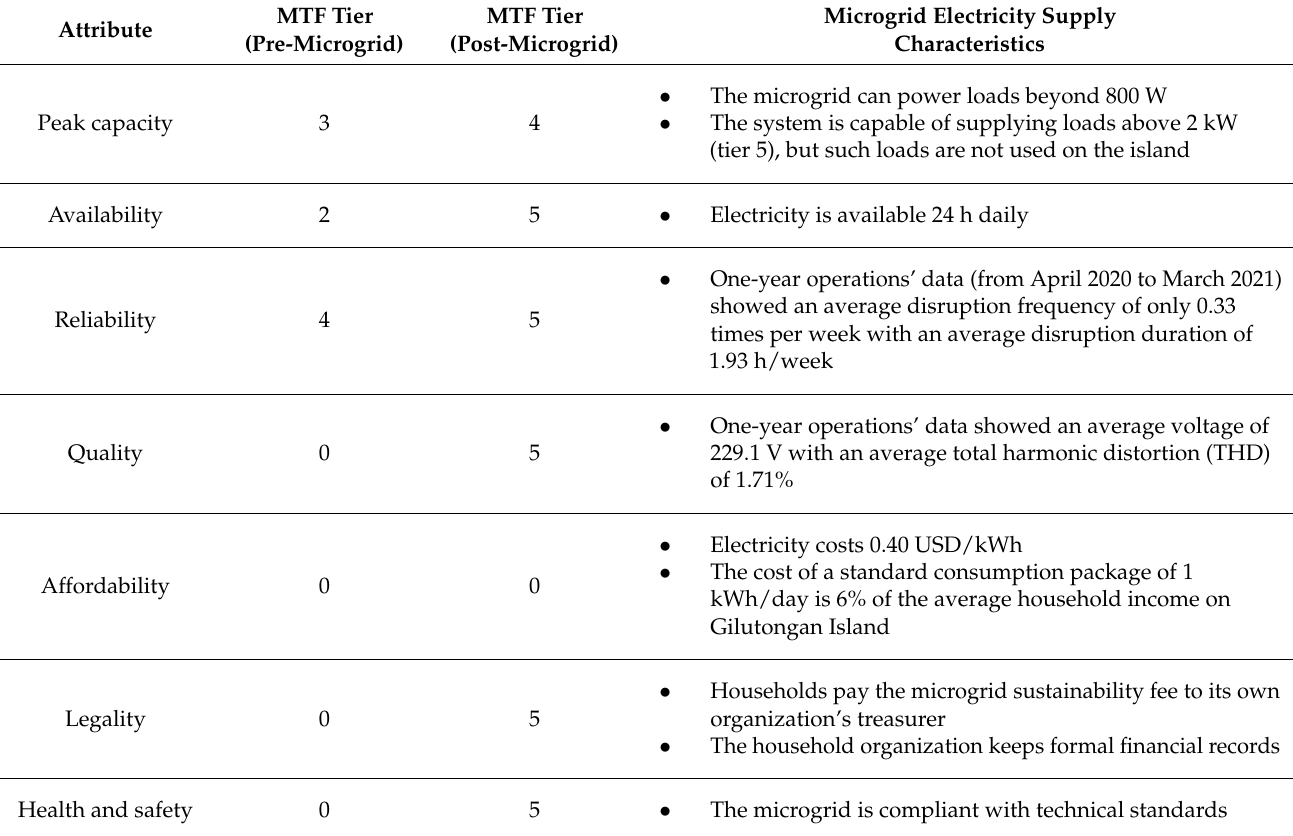
Table 12. Description of the electricity access on Gilutongan Island based on the multi-tier framework before and after the solar